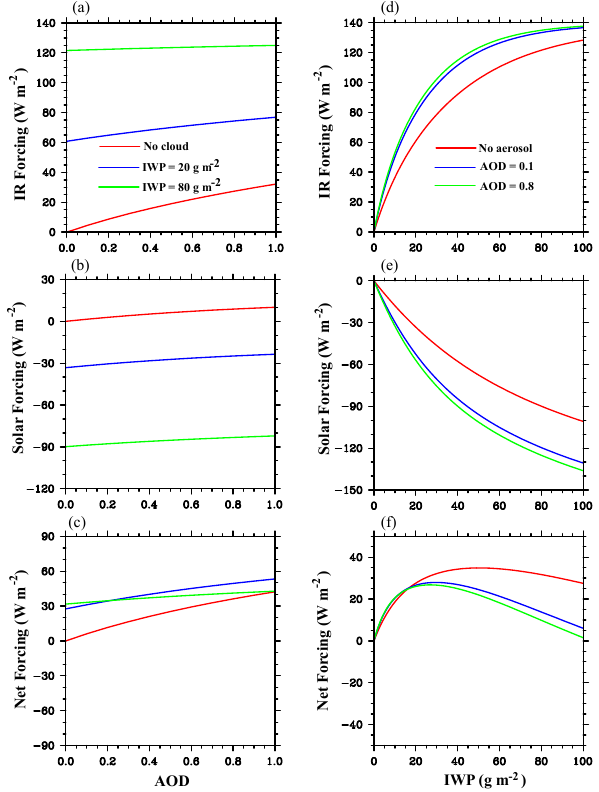
Fig. 4. Aerosol and cloud IR (a, d) , solar (b, e) , and net (c, f) forcings (Wm − 2 ) at TOA as a function of AOD (left panel) and IWP (right panel),